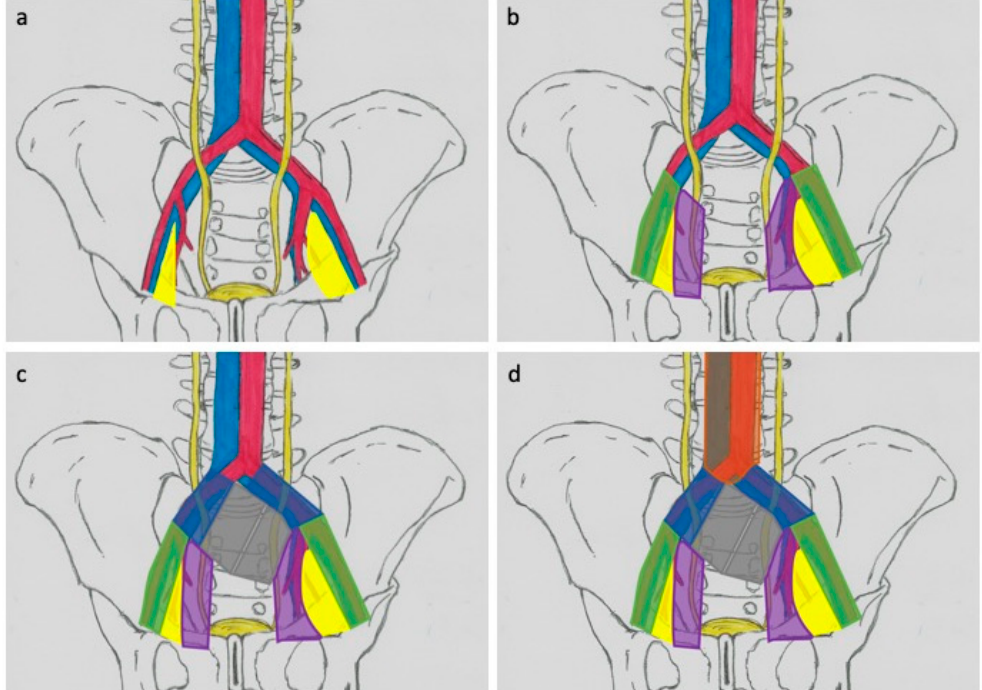
Figure 2. Anatomical diagram of lymphadenectomy divided into ranges: ( a )—limited, ( b )—standard, ( c )—extended, and ( d )—superextended (explanatory notes in the text); obturator area (yellow), external illiac vessels (green), internal illiac vessels (purple), common illiac vessels (navy), and presacral area (grey).